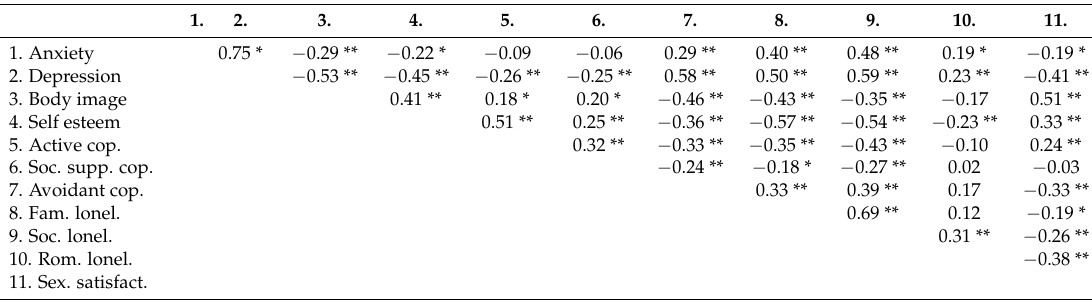
Table 2. Bivariate correlations for all the sample (men and women